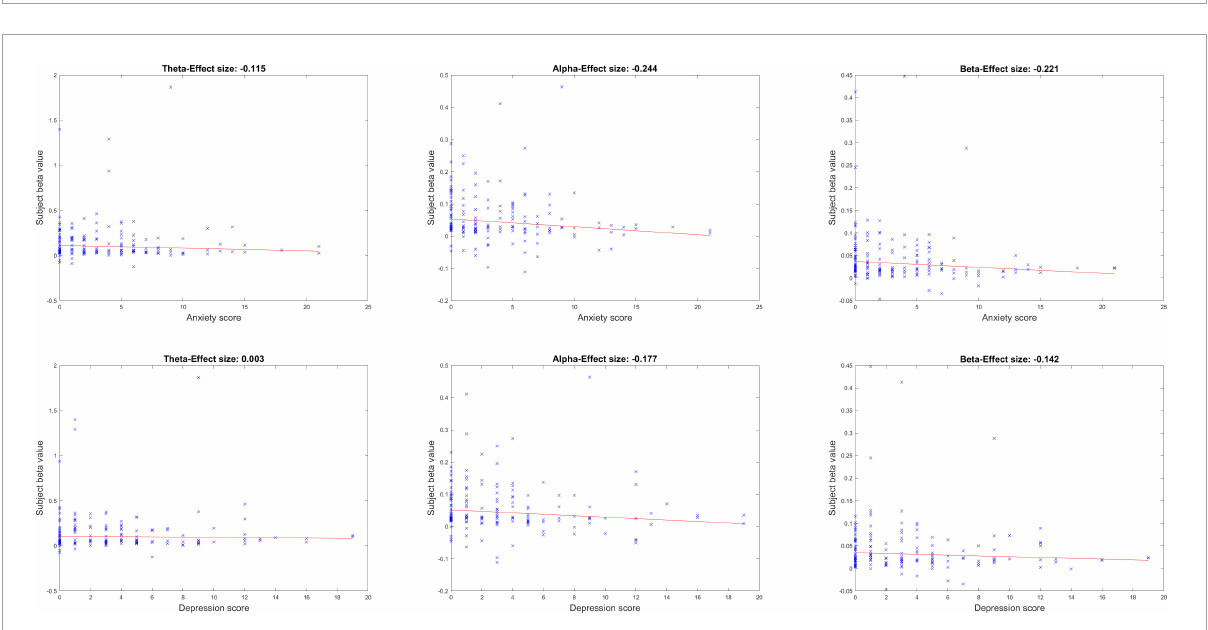
FIGURE3 Neurobehavioral correlations between peak ISC and mental health symptoms of anxiety and depression, across the three frequency